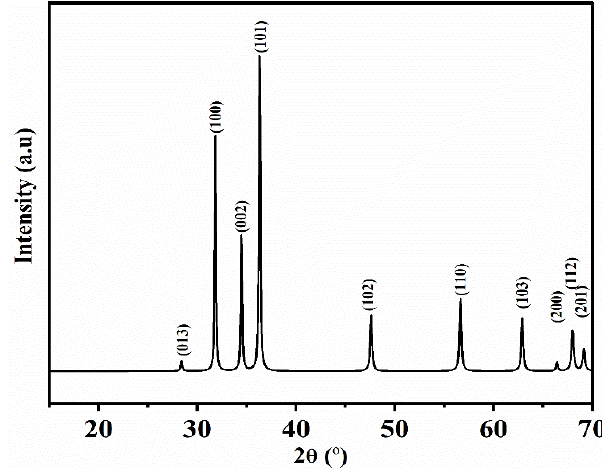
Figure 2. XRD spectra (standard ZnO diffraction pattern; JCPDS n°.01 ‐ 079 ‐ 2205) of ZnO ‐ NPs synthesized utilizing an aqueous extract from Phoenix dactylifera L.